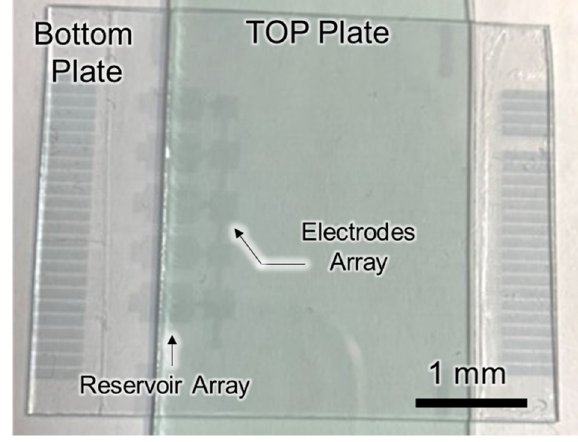
Figure 3. The digital microfluidic chip for immunoassay.